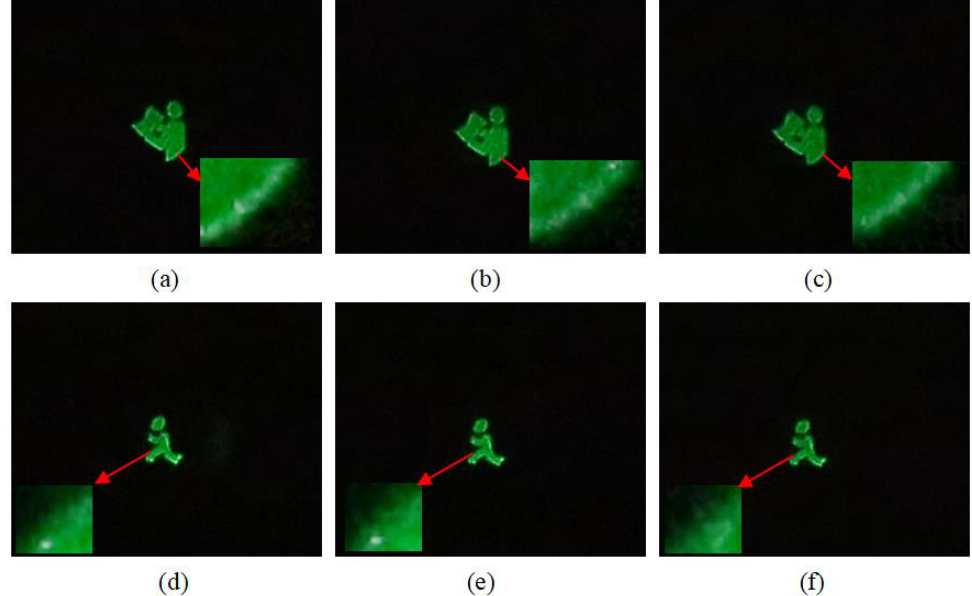
Figure 7. Optical experimental results of the reconstructed image. ( a , d ) Results of loading the full hologram without DOEs; ( b , e ) results of loading the effective hologram without DOEs; ( c , f ) results of loading the effective hologram with DOEs.